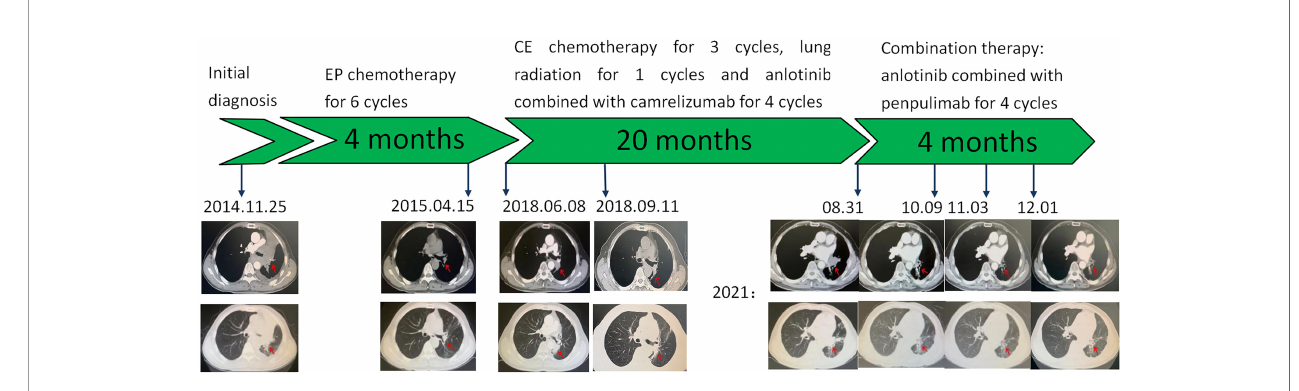
FIGURE 1 | Graphic timeline of